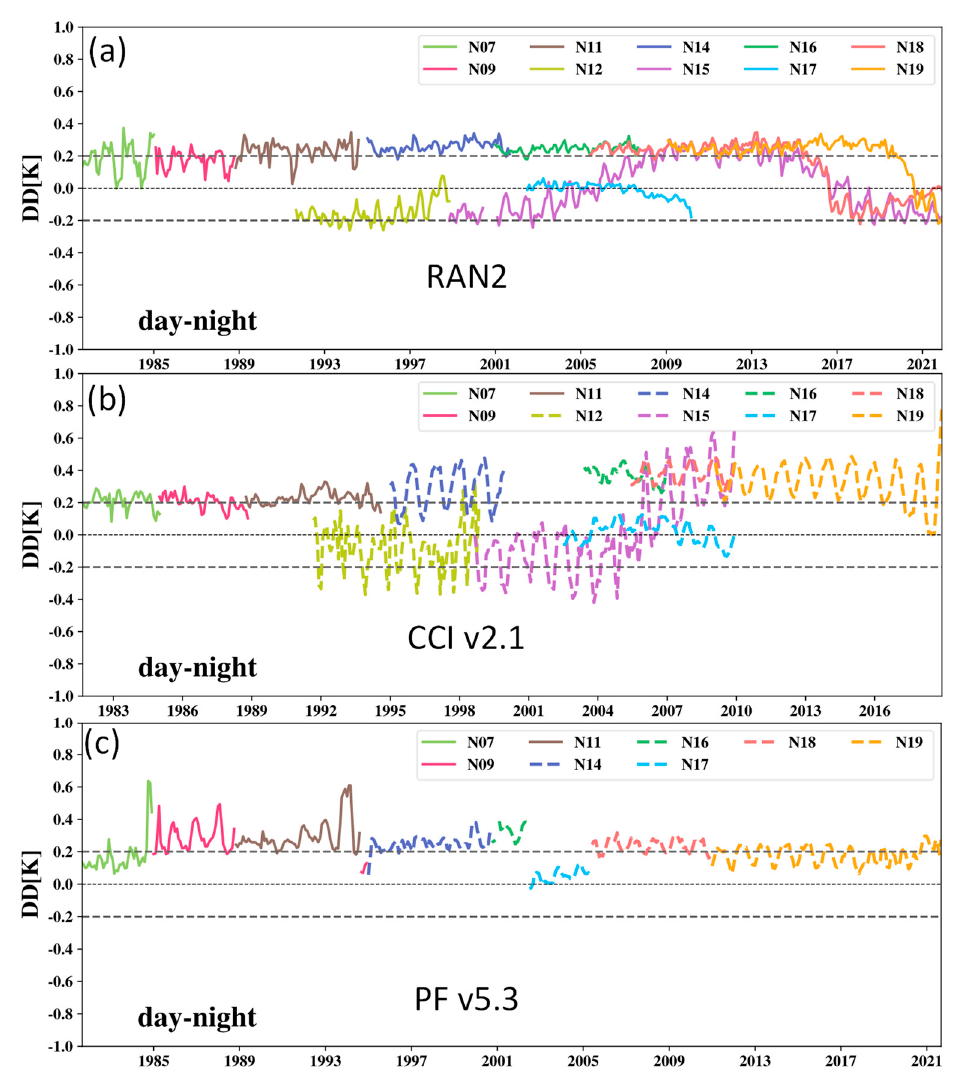
Figure 20. Time series of monthly averaged day − night double differences in ( a ) RAN2 ‘subskin’, ( b ) CCI, and ( c ) PF ‘skin’ + 0.17 K SSTs. (Data are from the NOAA SQUAM system [21,22].)